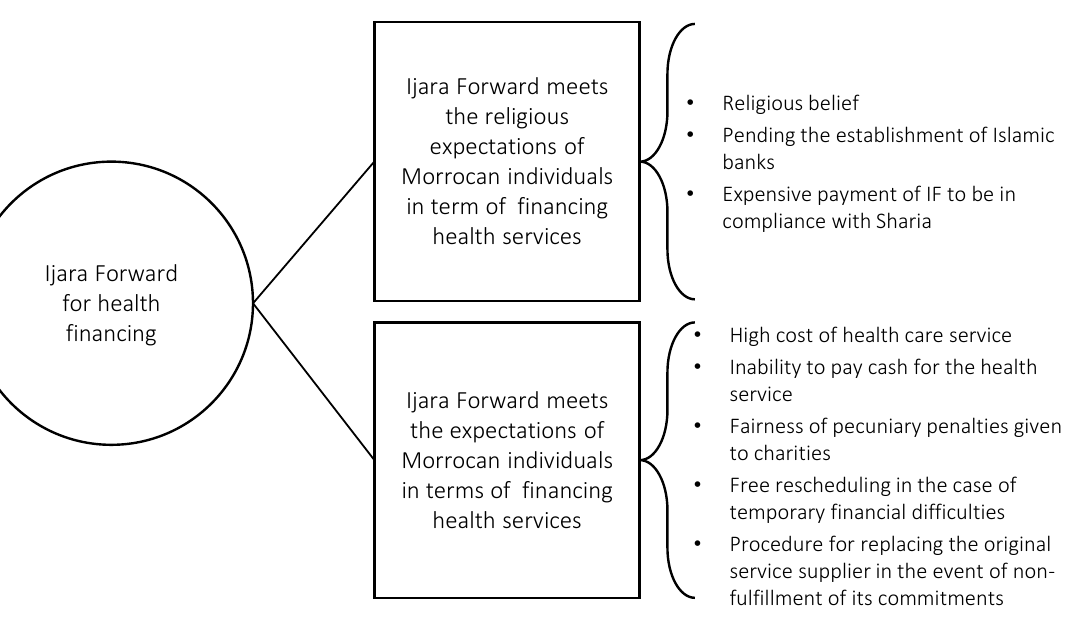
Figure 2. Research